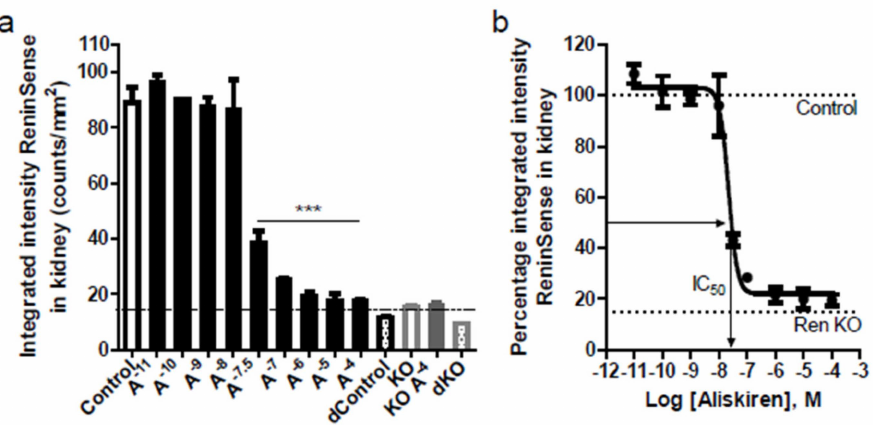
Figure 3. Specific in vitro enzymatic activation of ReninSense by kidney and plasma renin. ( a ) ReninSense was rapidly activated by kidney renin in WT mice. Low levels of fluorescence were found in RenKO kidney lysates comparable to the autofluorescence of the probe. High con- centrations of aliskiren completely blocked ReninSense activation. ( b ) The half-maximal inhibitory concentration (IC50) for aliskiren in kidney lysates was 10 − 7.7 M. Data are means ± SEM of duplicate samples. Note: *** p < 0.001 vs.